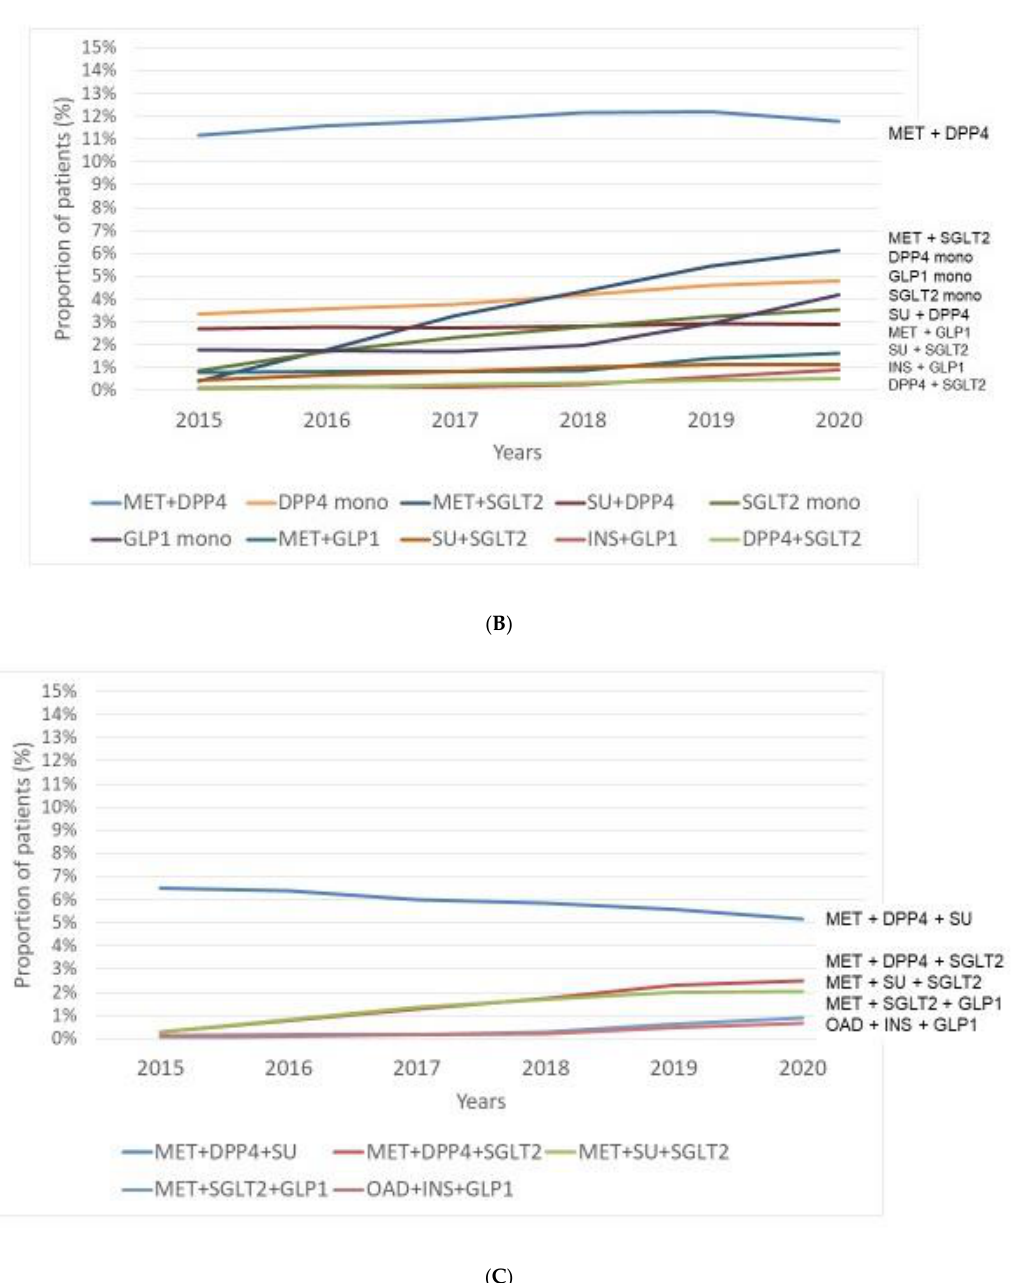
Figure 2. Treatment patterns of patients with type 2 diabetes mellitus (T2DM) in the period of 2015–2020. Prevalence of T2DM-patients treated with ( A ) traditional antihyperglycaemic agents in monotherapy or in combinations; ( B ) novel drugs in monotherapy or in dual combinations; ( C ) novel drugs in triple combinations. MET: metformin, INS: insulin, SU: sulfonylurea, OAD: oral antidiabetic drug, DPP4: dipeptidyl peptidase-4 inhibitor, SGLT2: sodium-glucose co-transporter-2 inhibitor, GLP1: glucagon-like peptide-1 receptor agonist, mono: